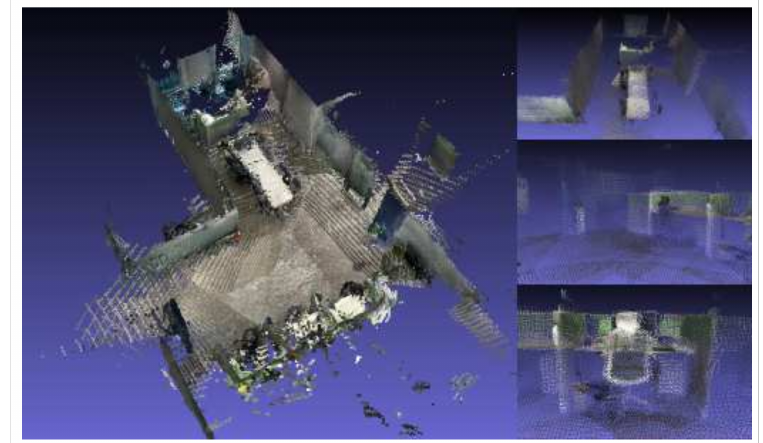
Figure 11. SLAM visualization results by RTAB-Map